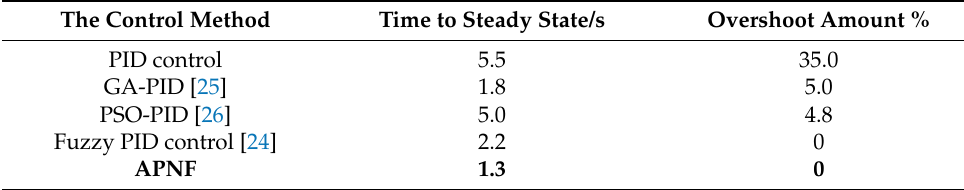
Table 2. Comparison of five control methods of system.